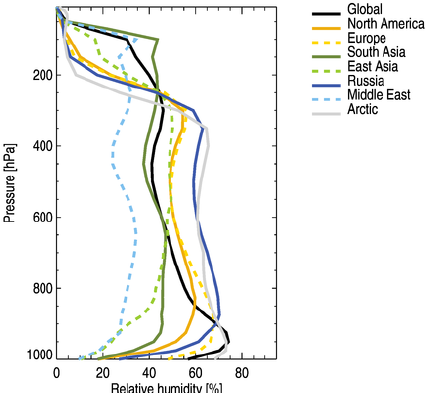
Figure 7. Annually averaged relative humidity from MERRA data, for year 2010, for the same regions as in Fig. 6.